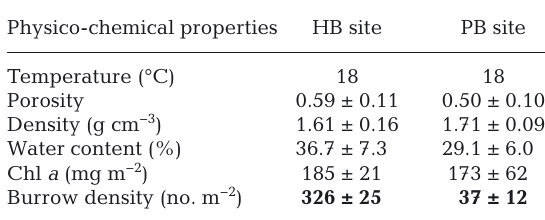
Table 1. Physico-chemical properties of surface sediment (0−2 cm depth) and burrow density at highly bioturbated (HB) and poorly bioturbated (PB) sites. Data are mean ± SE. Bold : significant difference between HB and PB sites (p <